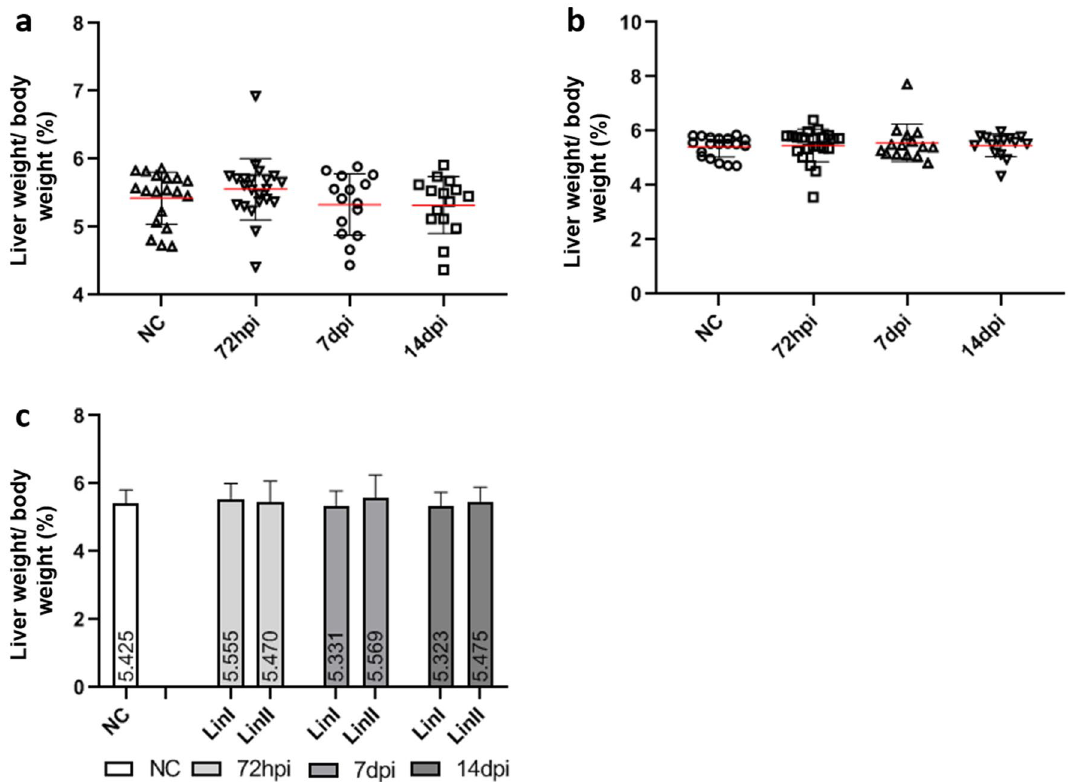
Figure 3. Liver weight / body weight ratio (%) of BALB/c mice uninfected and infected with DENV-2 Lineages 72 hpi, 7 and 14 dpi. ( a ) DENV-2 Lineage I; ( b ) DENV-2 Lineage II; ( c ) comparison of ratio